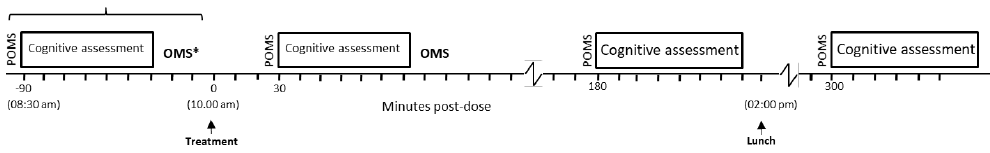
Figure 3. The timelines of the testing day for individual participants, showing the core cognitive assessment schedule. Profile of Mood States (POMS), 5 min Observed Multi-Tasking Stressor (*OMS) (methodology and results to be reported elsewhere).